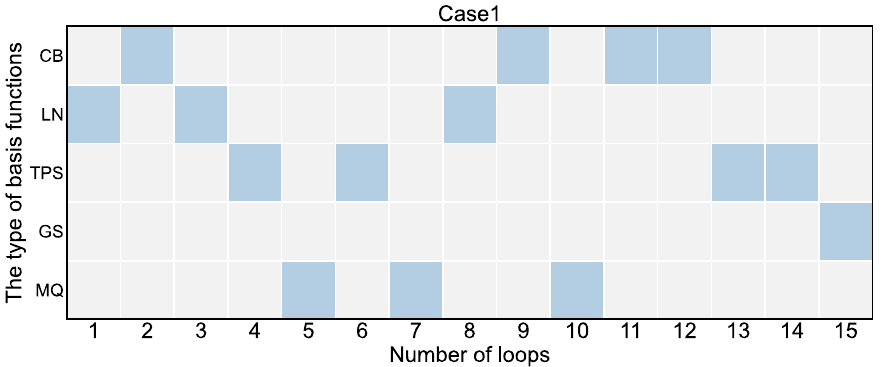
Figure 6. The usage of RBF of AST-SOM during optimization process in the solutions obtaining